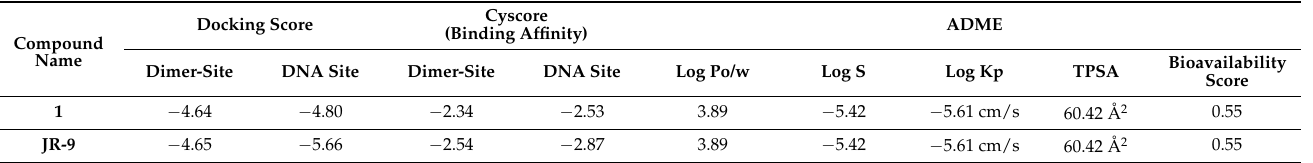
Table 1. The binding affinity of 1 and JR-9 was computed by Cyscore analysis, and the ADME properties were evaluated using